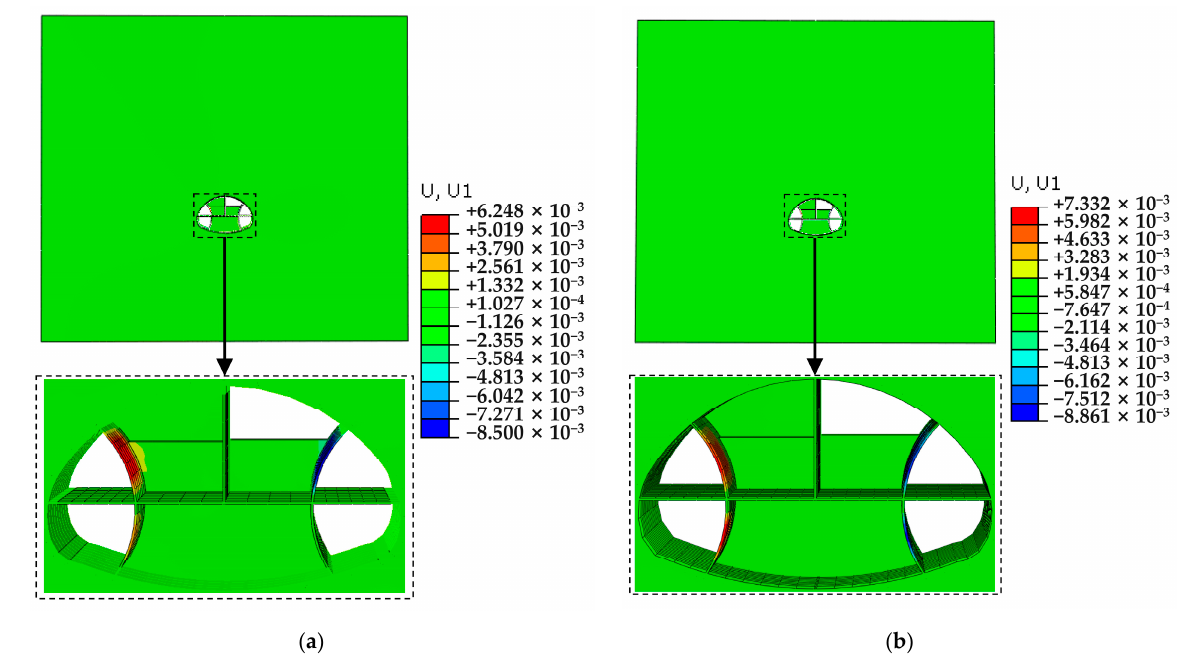
Figure 16. The horizontal displacement of surrounding rock under various conditions from excava- tion to target section (unit: m): ( a ) Condition 1 and ( b ) Condition